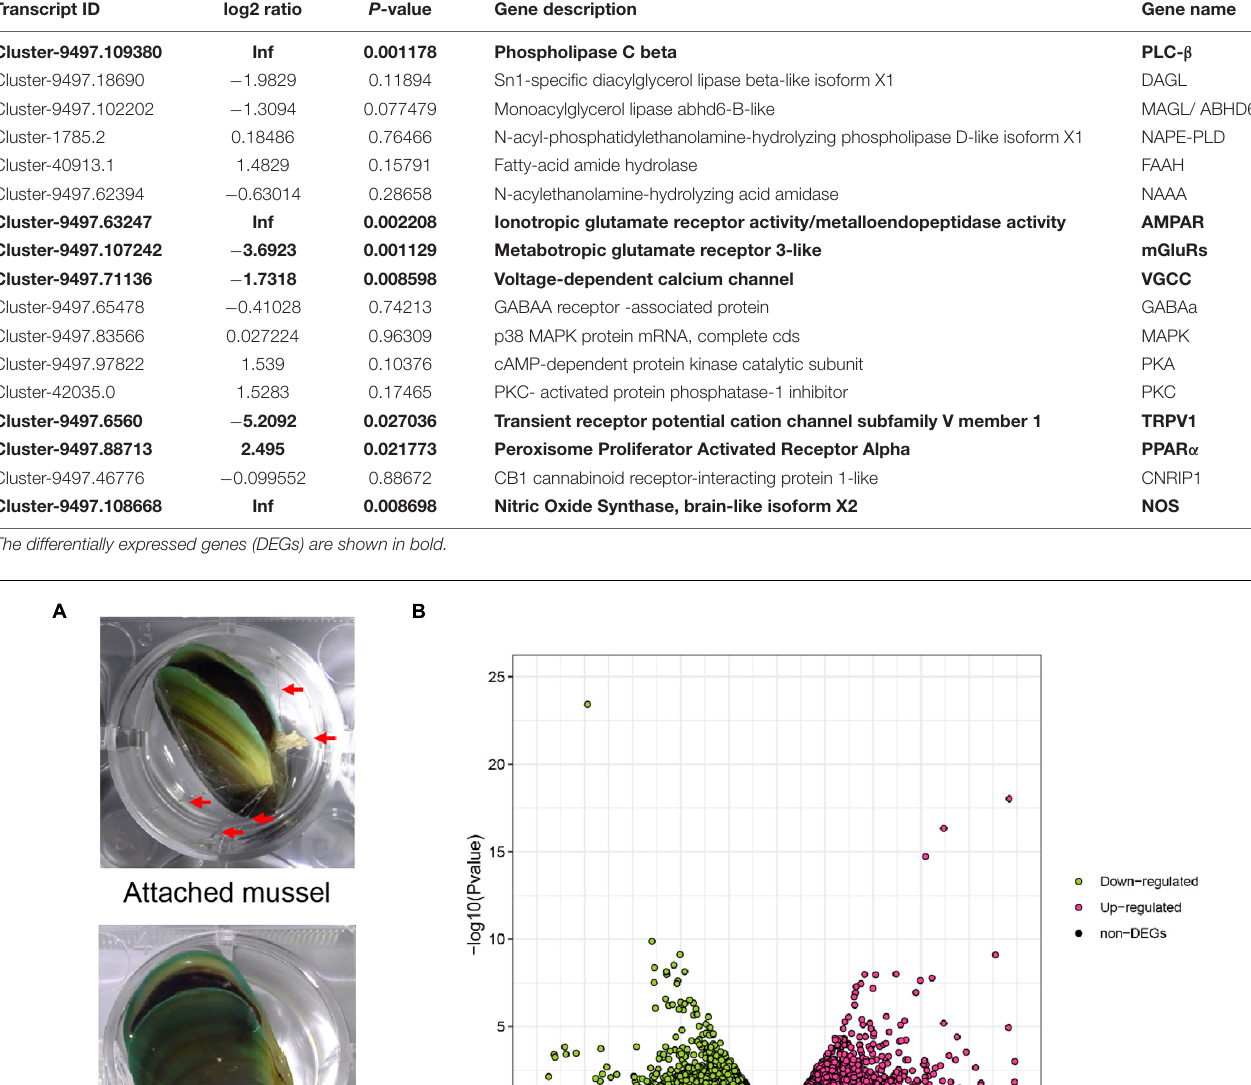
Validation of the transcriptome data using qRT-PCR was performed with six unigenes [FP1V-1 (Foot protein 1 variant), FP1V-2, FP4V-1, MAGL, PLC- β , and PKA]. As shown in Supplementary Figure 3 , the transcription profiles of all six selected unigenes as determined by qRT-PCR were consistent with those determined by RNA-seq, confirming the reliability and reproducibility of the transcriptome